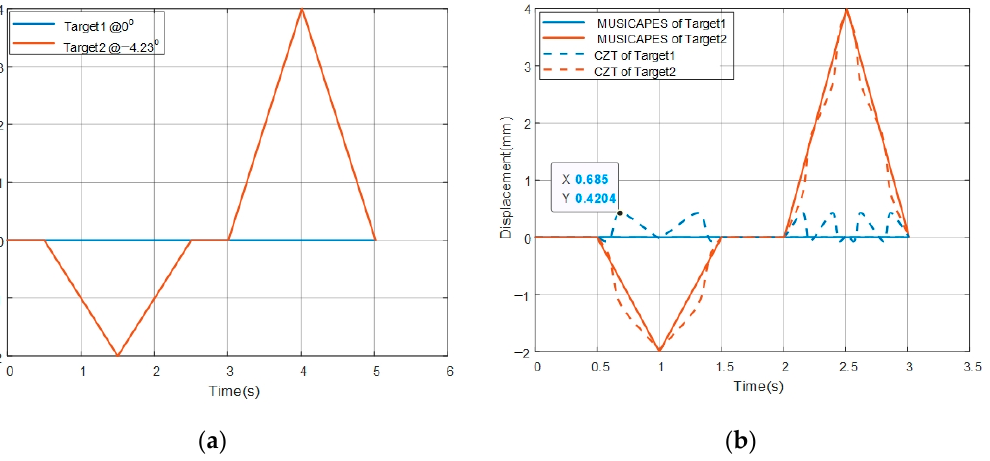
Figure 6. Displacement curves of the real value and the estimated ones. ( a ) The real value of displacement; ( b ) the displacement curves estimated by MUSICAPES and CZT.